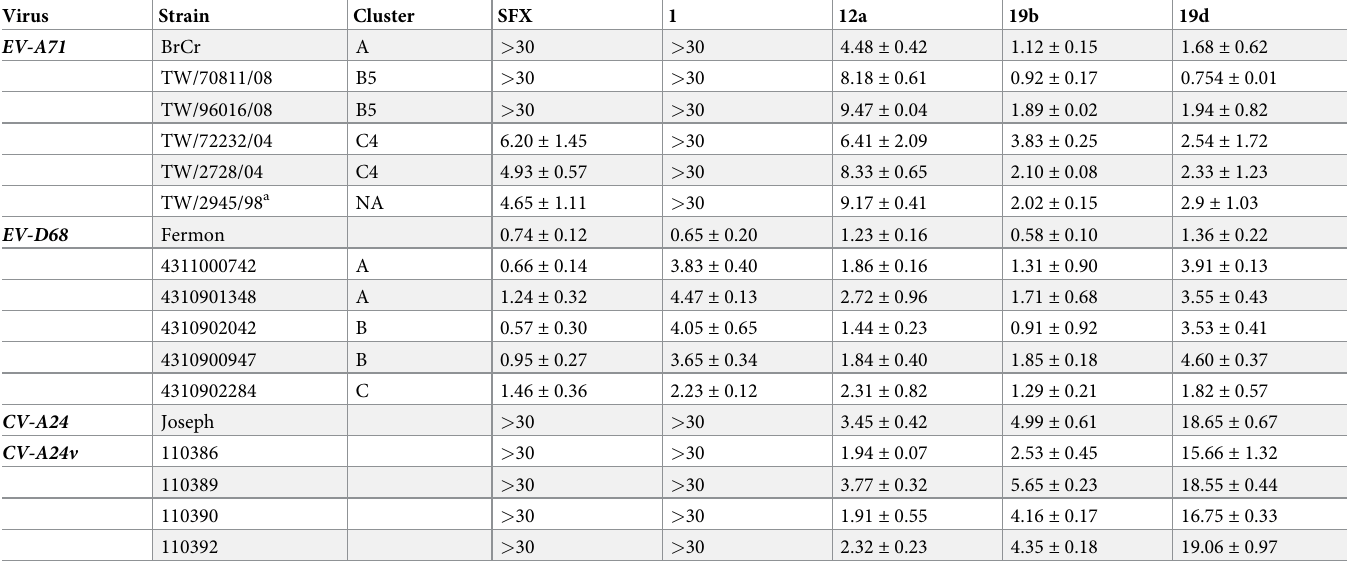
a Provided by Steve Oberste from the Centers of Disease Control and Prevention